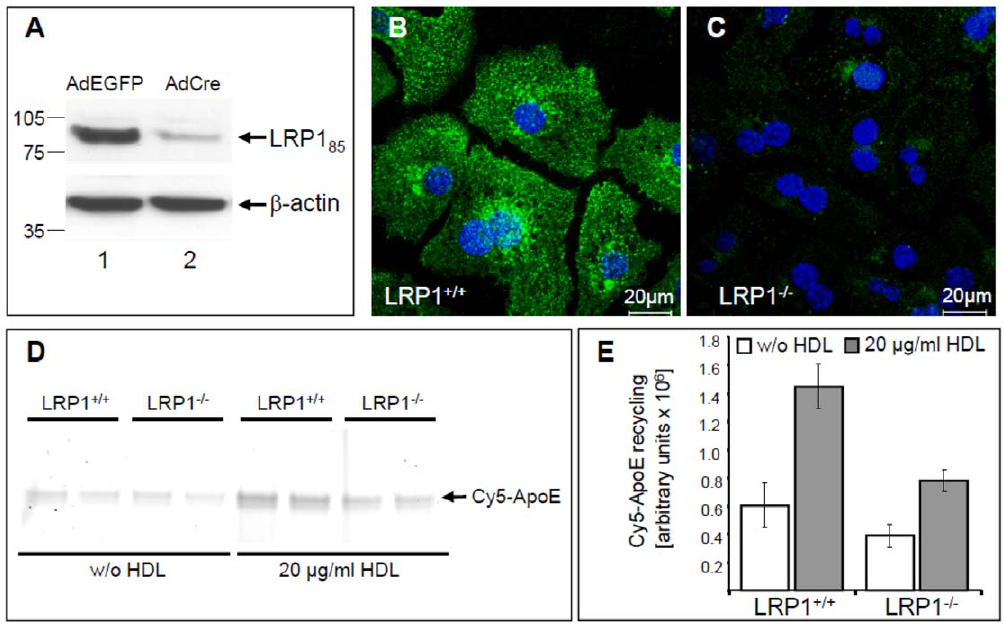
Figure 8. ApoE recycling is reduced in LRP1 2 / 2 primary hepatocytes. LRP1 flox mice were infected with AdEGFP or AdCre and three days after infection primary hepatocytes were isolated. Sixteen hours after seeding, the infection with AdCre resulted in a dramatic loss of LRP1 protein expression as determined by Western blotting (A) and indirect immunofluorescence (B–C). Pulse-chase experiments were performed by incubating LRP1-positive (LRP + / + ) and LRP1–negative (LRP 2 / 2 ) hepatocytes with Cy3-apoE-TRL for 60 min at 37 u C. Cells were washed with heparin and incubated for additional 60 min at 37 u C with media in the presence or absence (w/o) of 20 m g/ml HDL 3 . Then supernatants were harvested and the amount of re-secreted Cy3-apoE was determined by SDS-PAGE and subsequent quantification as described above. HDL-induced apoE recycling was reduced in LRP1 2 / 2 cells as seen by in-gel fluorescence of chase media (D). Quantification of 4 independent experiments 6 S.E.M. revealed a strong reduction of HDL-induced apoE recycling in LRP1 2 / 2 hepatocytes 6 HDL (E).